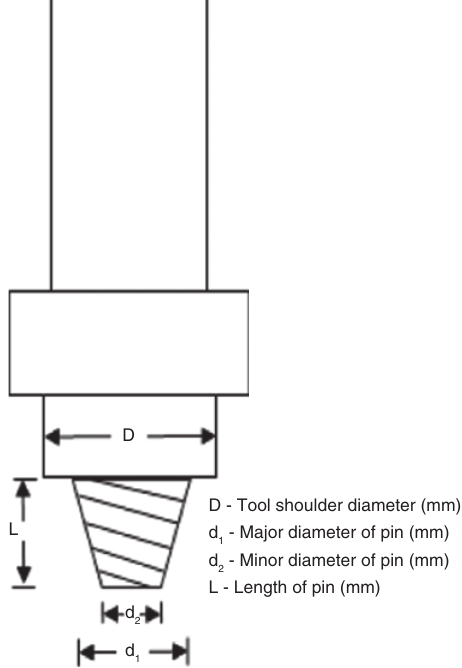
Figure 2: Schematic diagram of FSW tool.